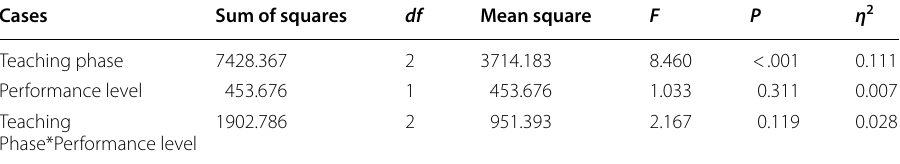
Table 2 Results of two-way ANOVA of engagement with teaching phase and performance level Cases